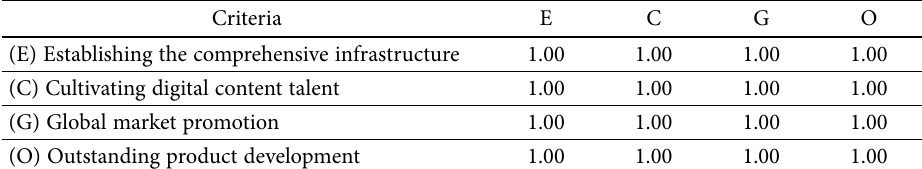
Table 3. The matrix of all criteria